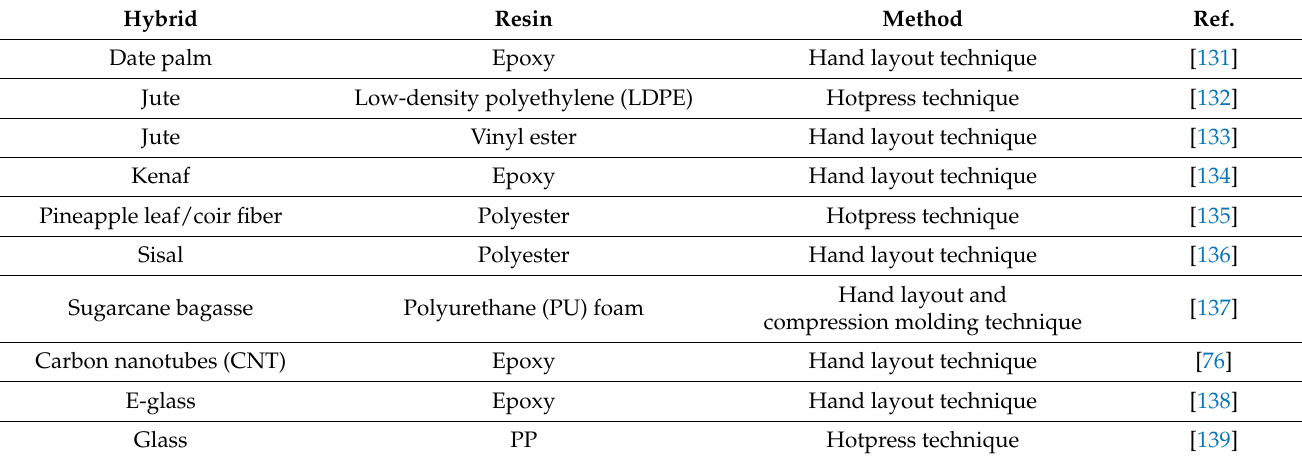
Table 12. Bamboo-reinforced polymer hybrid composites and preparation